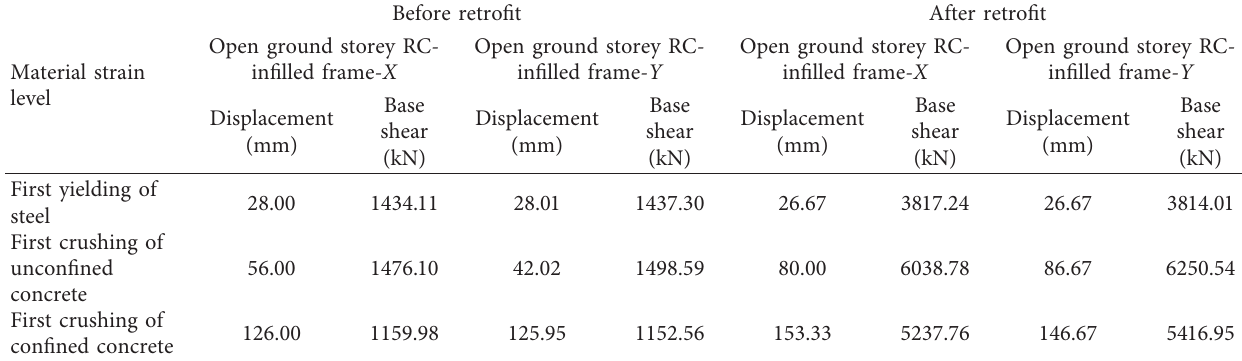
Table 7: Material strain level of the open ground storey RC-infilled frame.